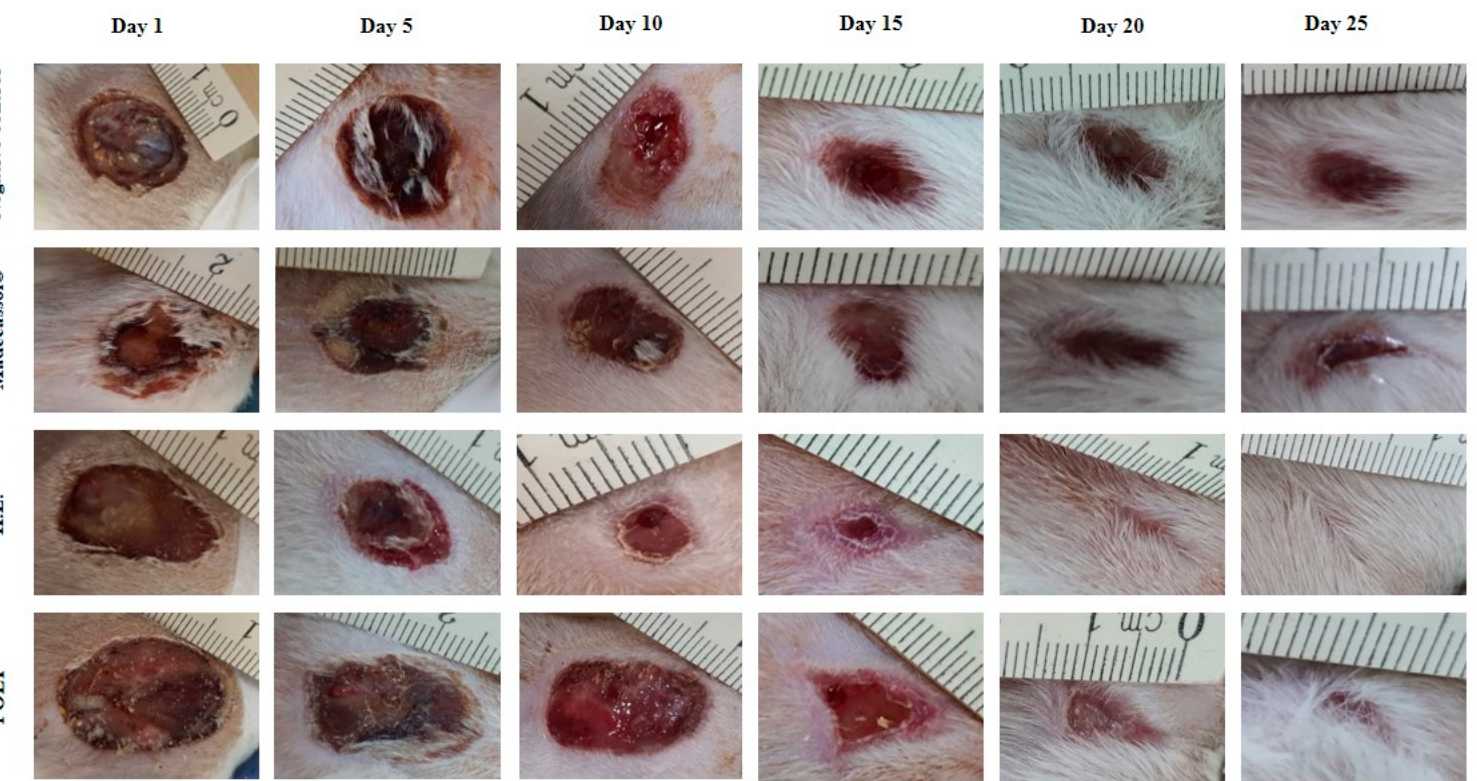
Figure 5. Morphological aspects of cutaneous burn healing process upon application of the hydro-ethanolic (H.E) and Poly (Polyphenols) extracts of P. sativum Hoffm. and the control groups during 25 days of treatment. The rate of the healing activities induced by each application were compared to each other. As shown in Figure 6, the hydro-ethanolic and polyphenols extracts elicited a high wound contraction at the 5th day by 46.45% and 38.7%, respectively. At the 25th day, the hydro-ethanolic extract elicited the highest healing (up to 97.17%), followed by the polyphenols and Madecassol ointment with almost the same percentage of inhibition (94.98% and 94.27%, respectively) while the negative control group was improved by only 80.62%.